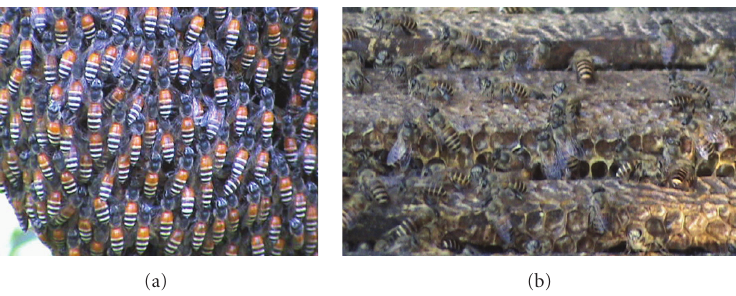
Figure 2: Cultivated species of honeybee in India (a) Apis mellifera , and (b) Apis cerana